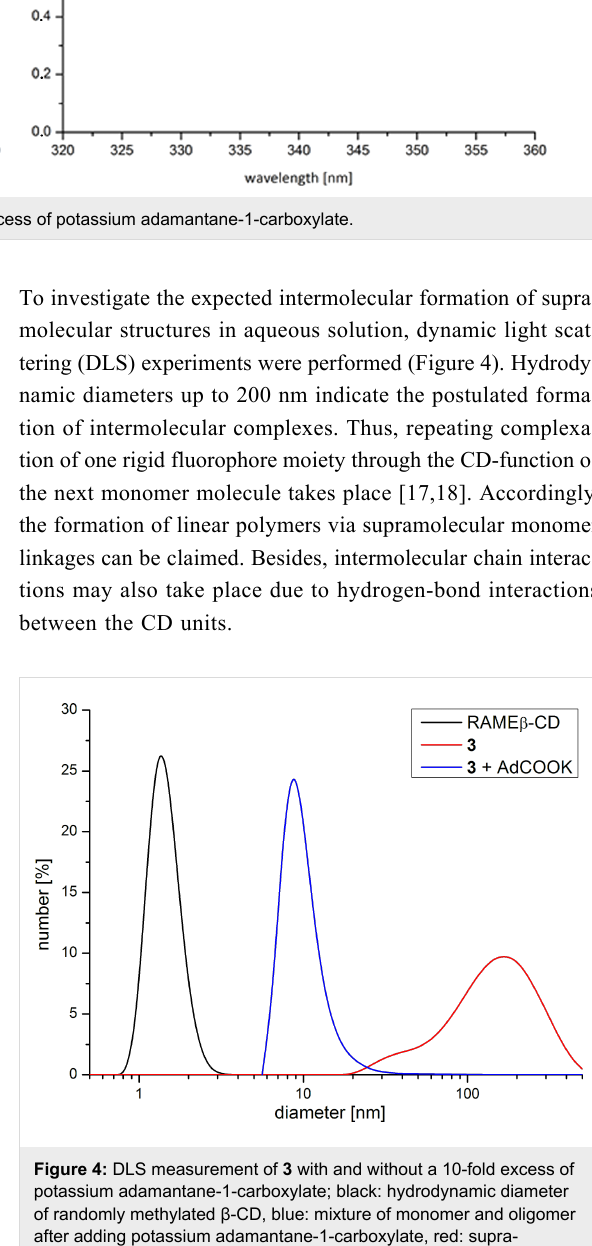
Figure 4: DLS measurement of 3 with and without a 10-fold excess of potassium adamantane-1-carboxylate; black: hydrodynamic diameter of randomly methylated β -CD, blue: mixture of monomer and oligomer after adding potassium adamantane-1-carboxylate, red: supra- molecular polymer of 3